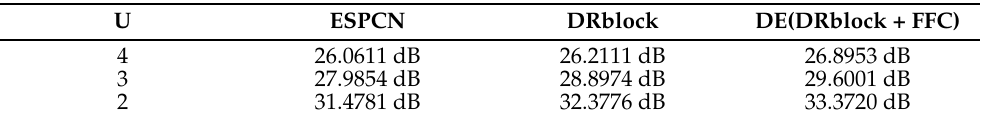
Table 1. Comparison experiment of the proposed DE module, when different settings were adopted, using the Inria aerial dataset.